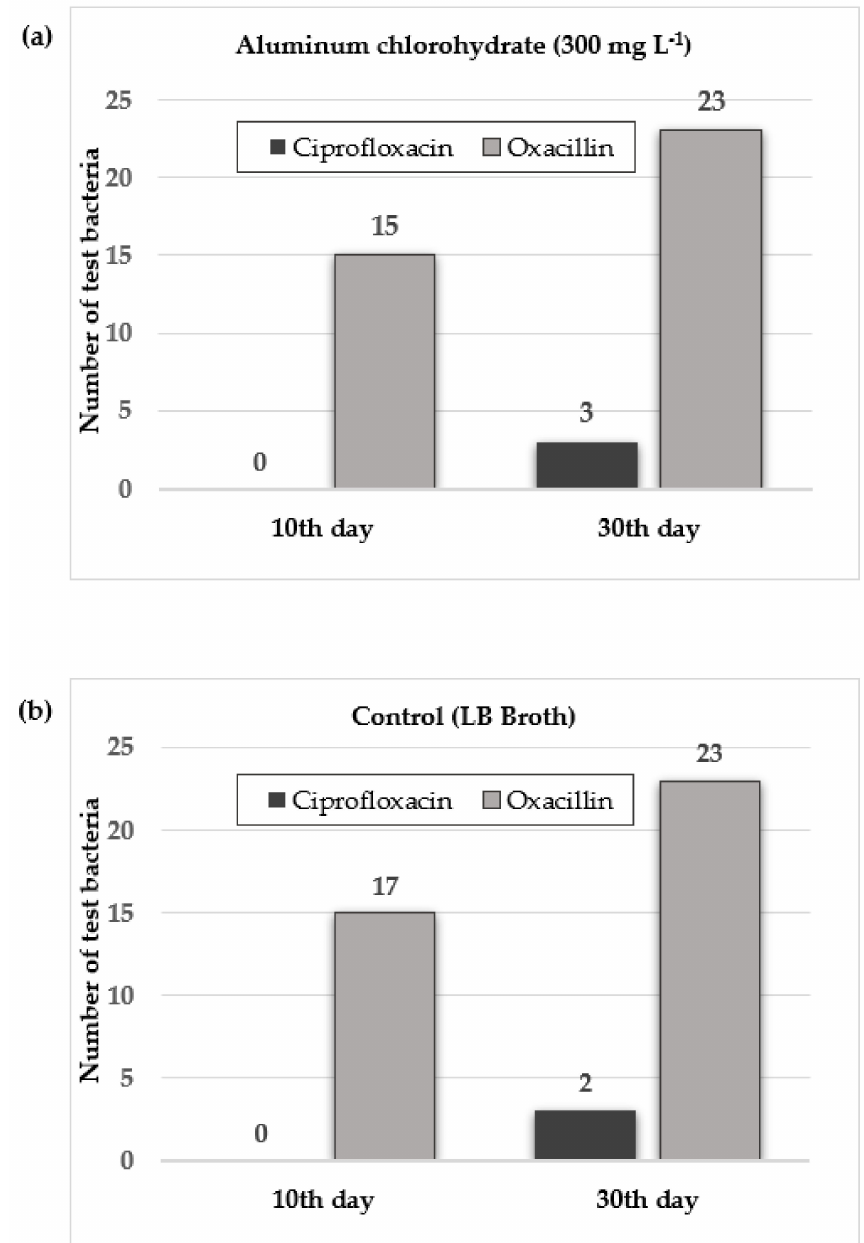
Figure 2. Phenotypic antibiotic resistance development of susceptible test bacteria on the 10th and 30th days of the exposure. ( a ) Aluminum chlorohydrate (300 mg/L) exposure. ( b ) Control (susceptible test bacteria subcultured in LB broth without aluminum